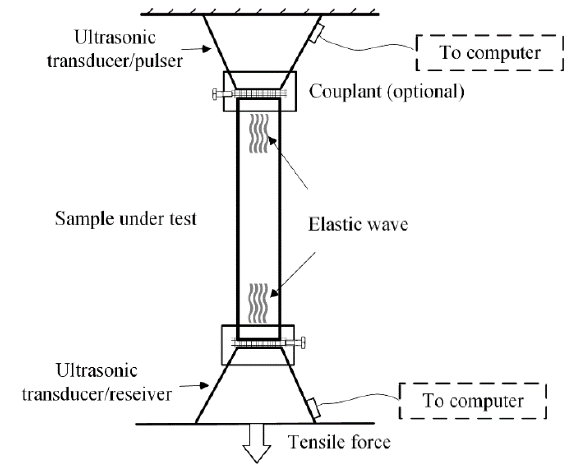
Figure 4. Stress measurement scheme by pulsed ultrasound.